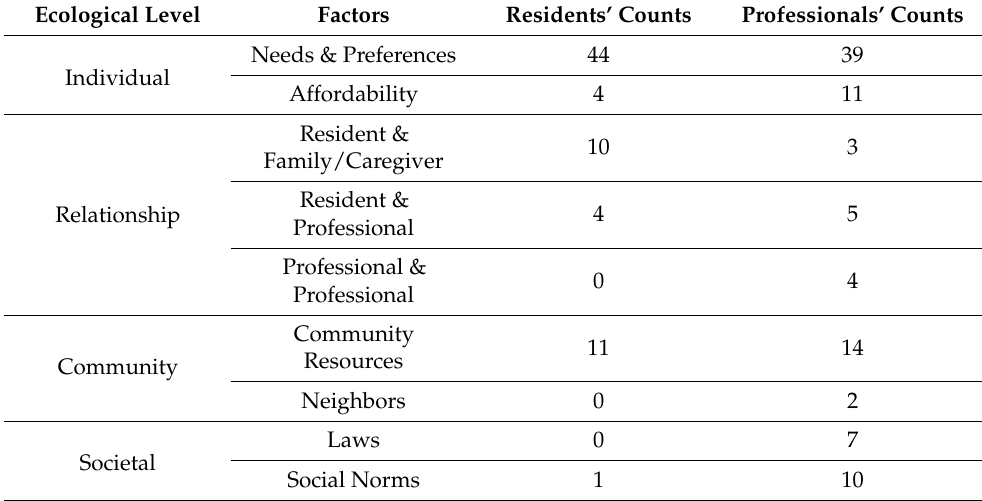
Table 1. Focus groups factors informed by the Centers for Disease Control and Prevention’s (CDC, 2021) social-ecological framework by level, factors, residents’ counts, and professionals’ counts ( N = 16).